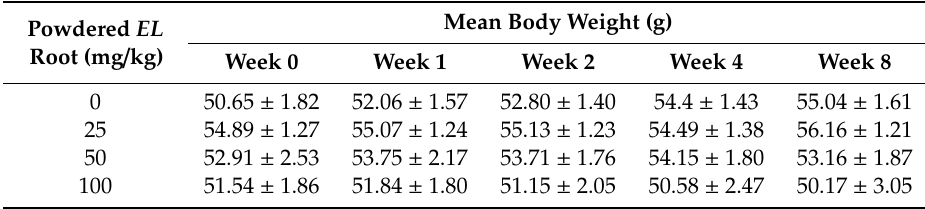
Table 1. The mean body weight of db / db mice involving control and powdered E. longifolia root treatments.